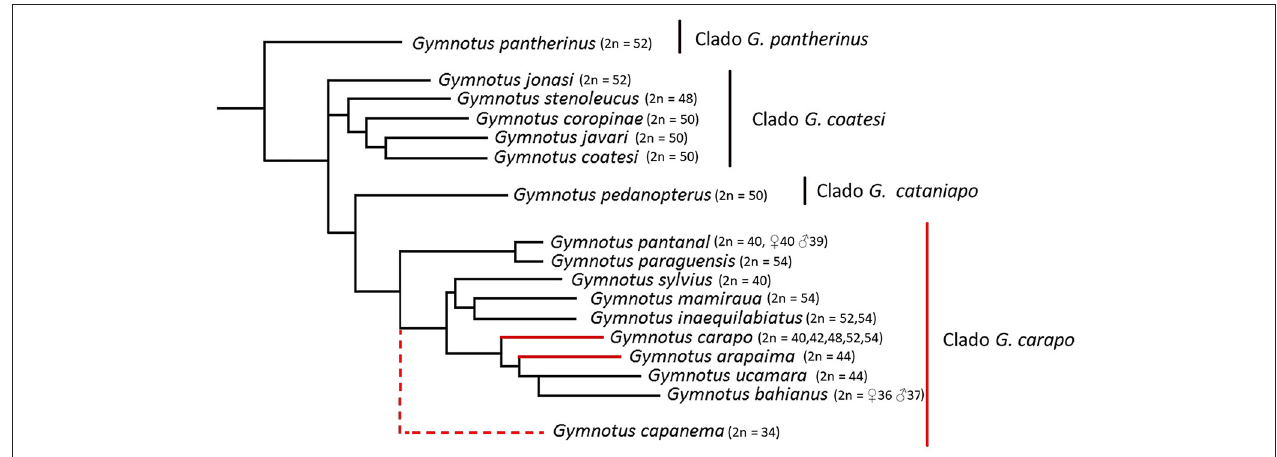
FIGURE 1 | Representative tree of species of Gymnotus with diploid number known (Data present in Table 1 ). It was included only species with know phylogenetic relationships, based on data from Albert et al. (2005) and Tagliacollo et al. (2016). G. capanema was included in the G. carapo clade based on Milhomem et al. (2012a) , but has unclear place within the clade.